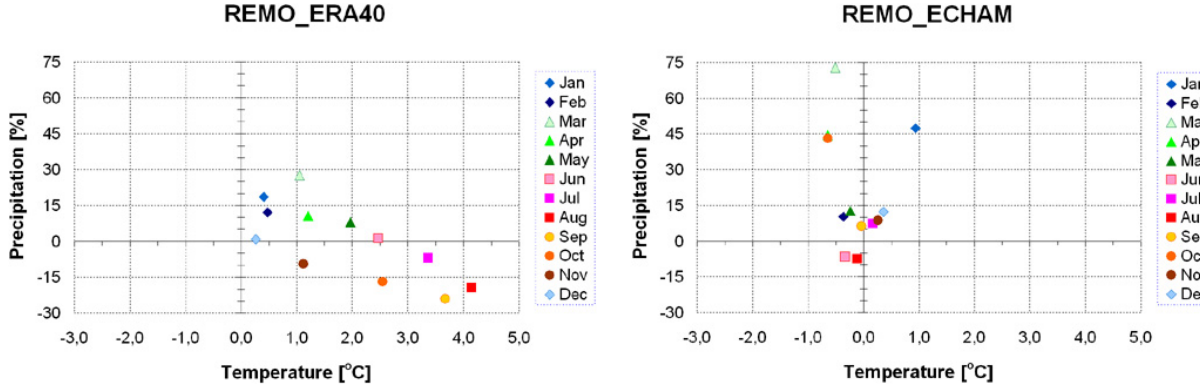
Figure 5. Monthly mean precipitation and temperature di ff erences [% and ◦ C, respectively] between the REMO simulations (ERA40-driven REMO on the left, ECHAM-driven REMO on the right) and the CRU1.2 observations over Hungary for 1961–1990.